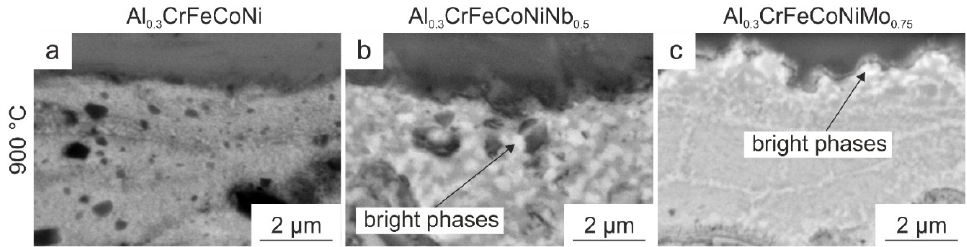
Figure 9. Magnified SEM (BSE) images of the wear tracks of the HVOF-sprayed ( a ) Al 0.3 CrFeCoNi, ( b ) Al 0.3 CrFeCoNiNb 0.5 and ( c ) Al 0.3 CrFeCoNiMo 0.75 , after testing at 900 °C. The interface of the HEA coatings is convoluted except for the Al 0.3 CrFeCoNi coating. In addition, the Nb- and Mo-containing HVOF-sprayed coatings exhibit bright and coarse phases close to the oxide layer.